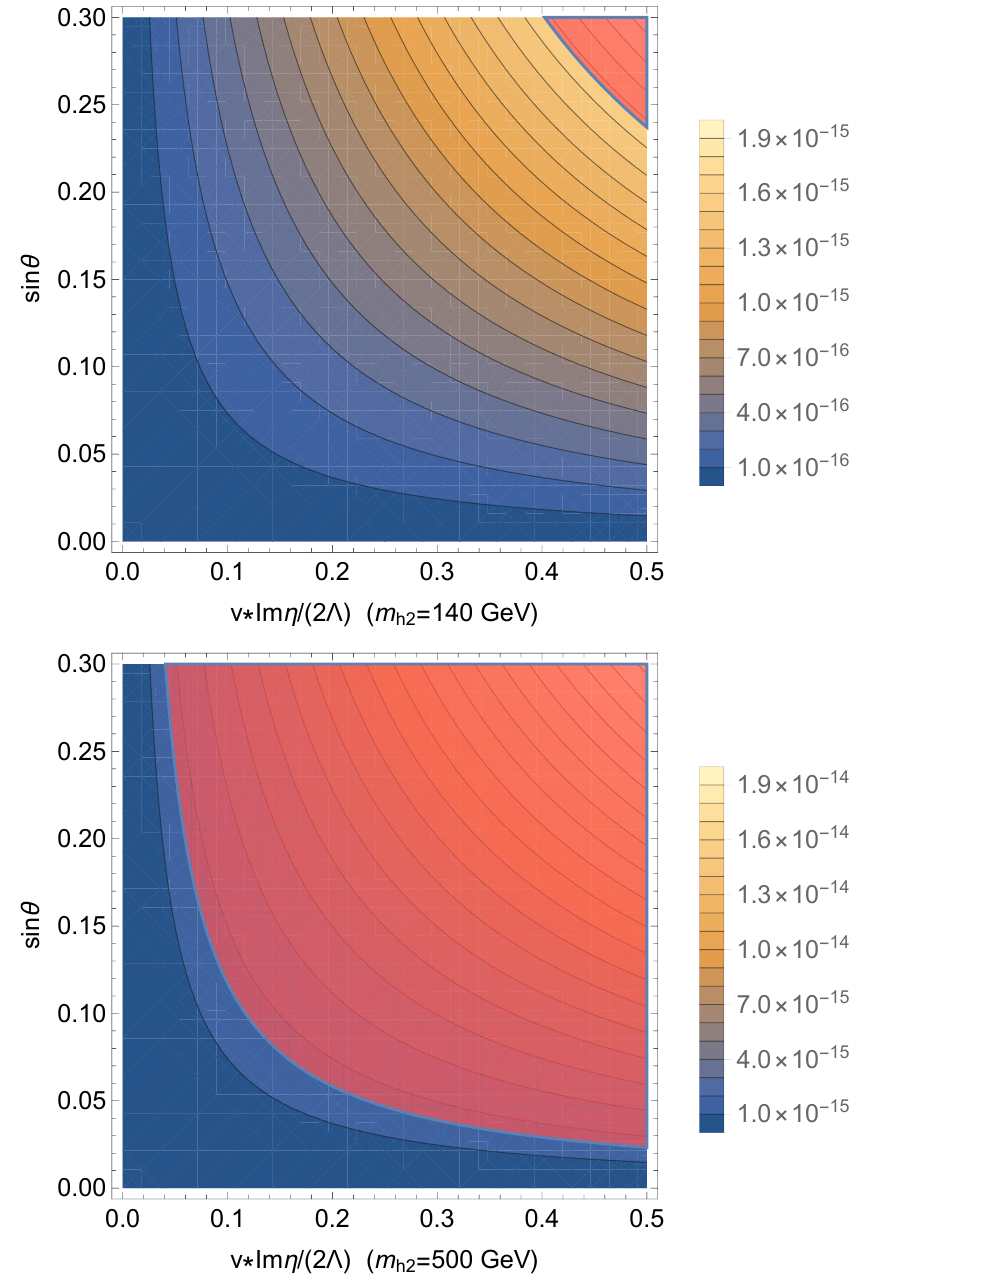
Figure 5 . The contours showing the e EDM contributions in the SM+RS model for m h (top) and m h = 500 GeV (bottom). The red region is ruled out by experimental 2